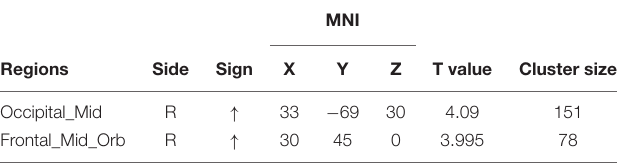
TABLE 5 | Changes of mPFC rsFC in the lower response